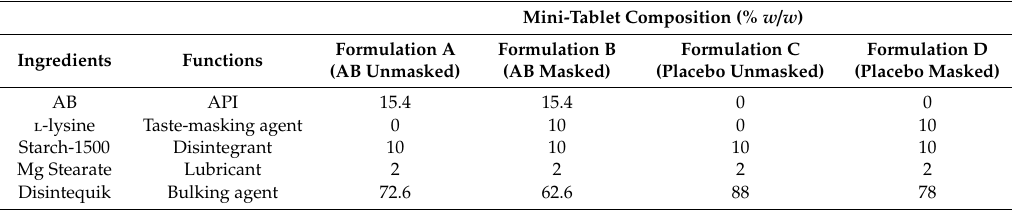
Table 1. Composition of mini-tablets containing Amlodipine Besylate (% w / w